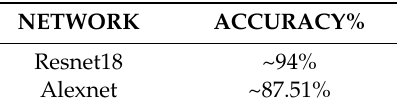
Table 5. Table comparing Resnet18 and AlexNet networks (the comparison concerned the values of features of one video material.